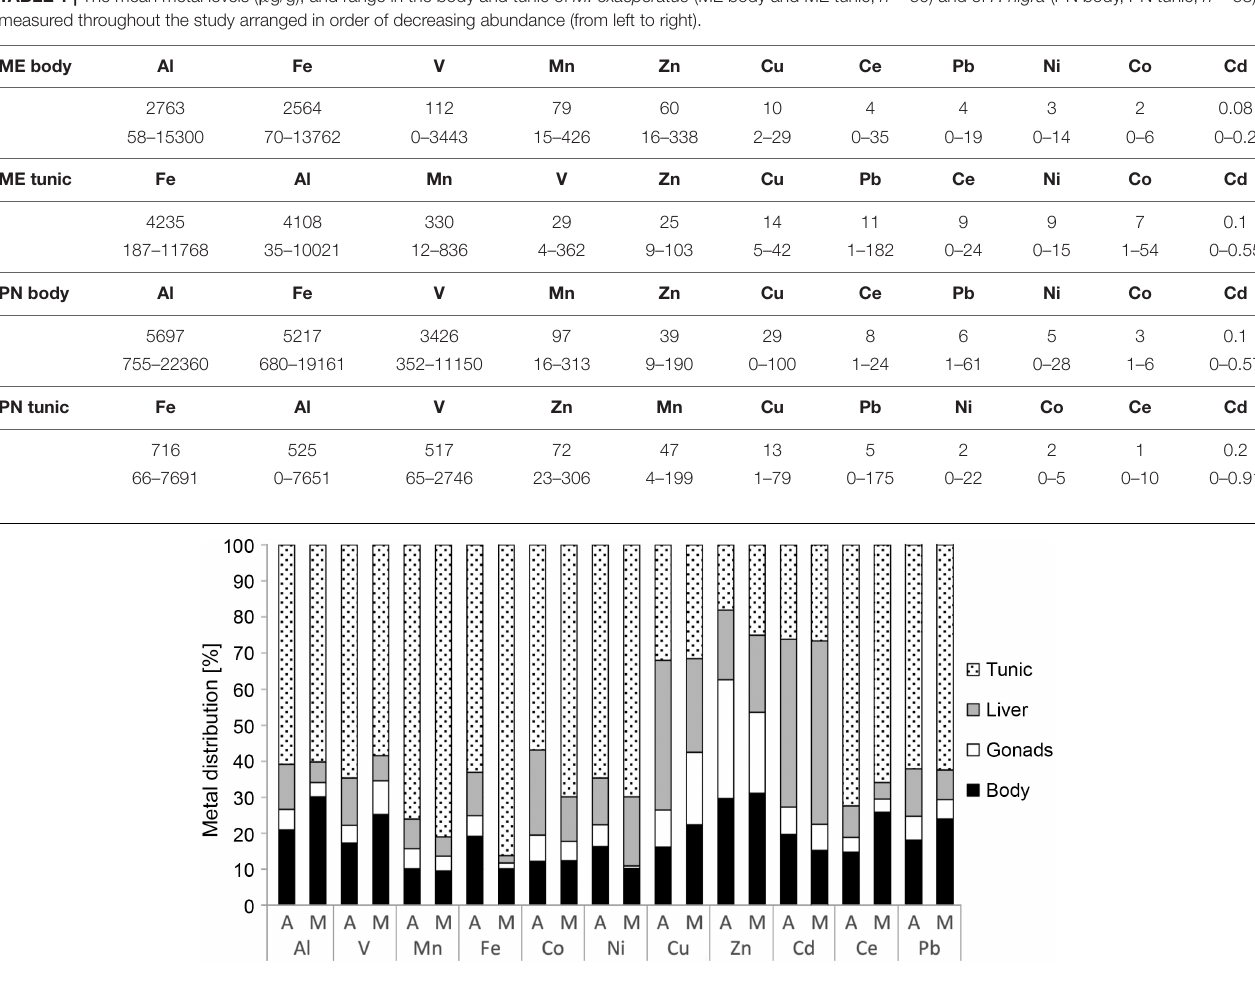
FIGURE 6 | Metal distribution in the different tissues of M. exasperatus (tunic, body, gonads, and liver), from samples collected from Akko (A) and Mikhmoret (M), in summer 2016, winter 2017, and spring 2017. The data are presented as% of mean concentration ( n = 28).